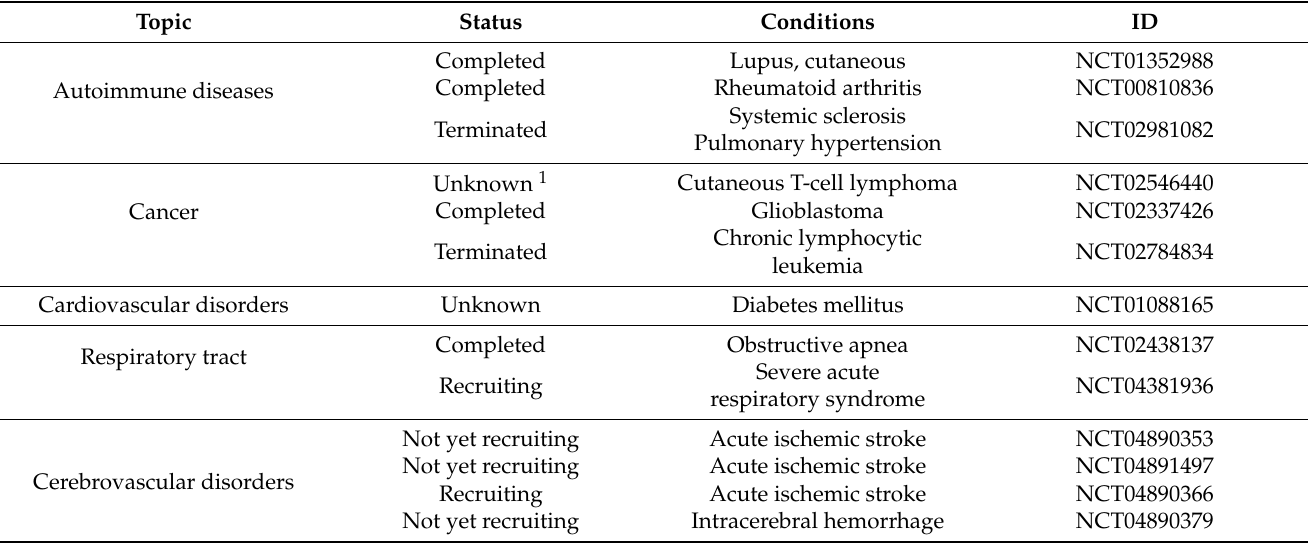
Table 1. Clinical trials involving DMF/MMF in different diseases. Exclusion criteria: patients involving a diagnosis of MS or psoriasis. The terminated trials were interrupted for low